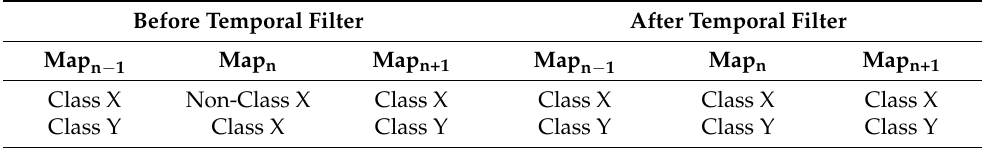
Table 3. Post-classification temporal filter applied to our land-use maps. It searches for deviations in the central timestep of three consecutive maps and changes it according to the following rules. Before Temporal